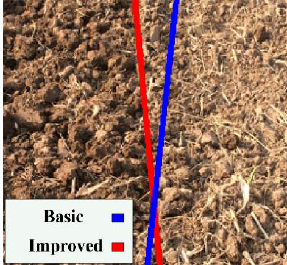
Figure 14. Results of Hough transform.